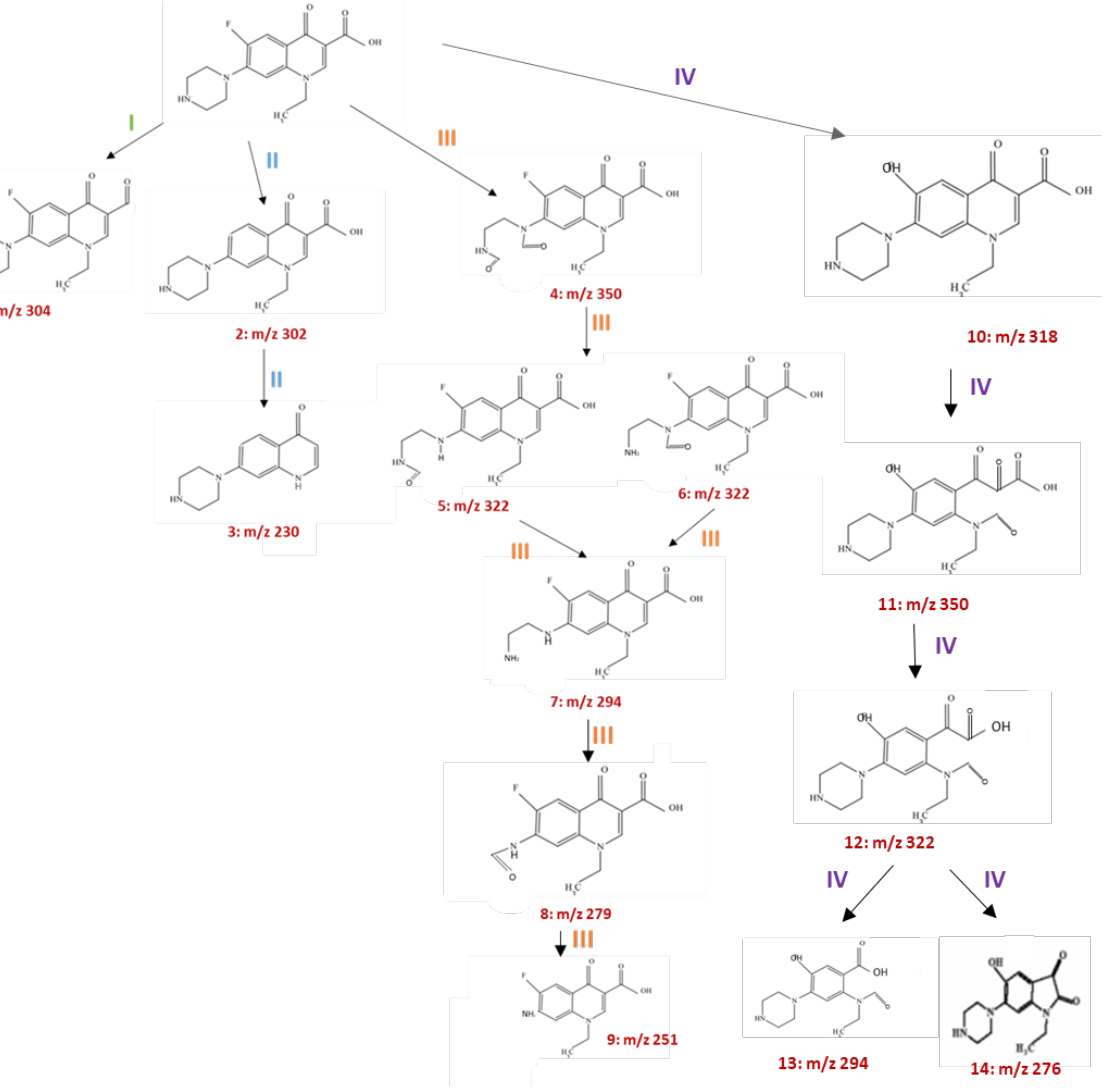
Figure 8. Proposed mechanism for the degradation of norfloxacin; four main pathways are presented. High-resolution liquid chromatography mass spectrometry was used to determine the produced degradation intermediates. There are 4 suggested pathways; in the first pathway, the norfloxacin is degraded by dehydroxylation reaction. In the second pathway, structure 2 is produced by defluorination reaction, which is transmitted to structure 3 by decarboxylation and deethylation reaction. The third pathway is characterized mainly by the removal of piperazinyl group; in this pathway, ring opening occurs, and 6 intermediates are produced. The fourth pathway is characterized by the opening of the quinolone substituent and the benzene moiety. Adapted from [100].